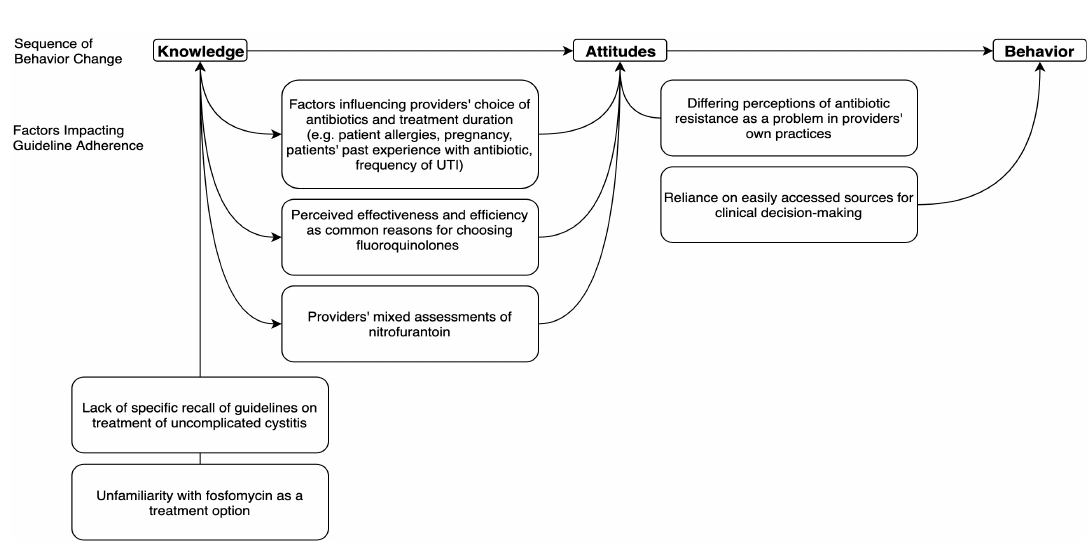
Figure 1. Mapping of the identified themes to the Cabana framework.